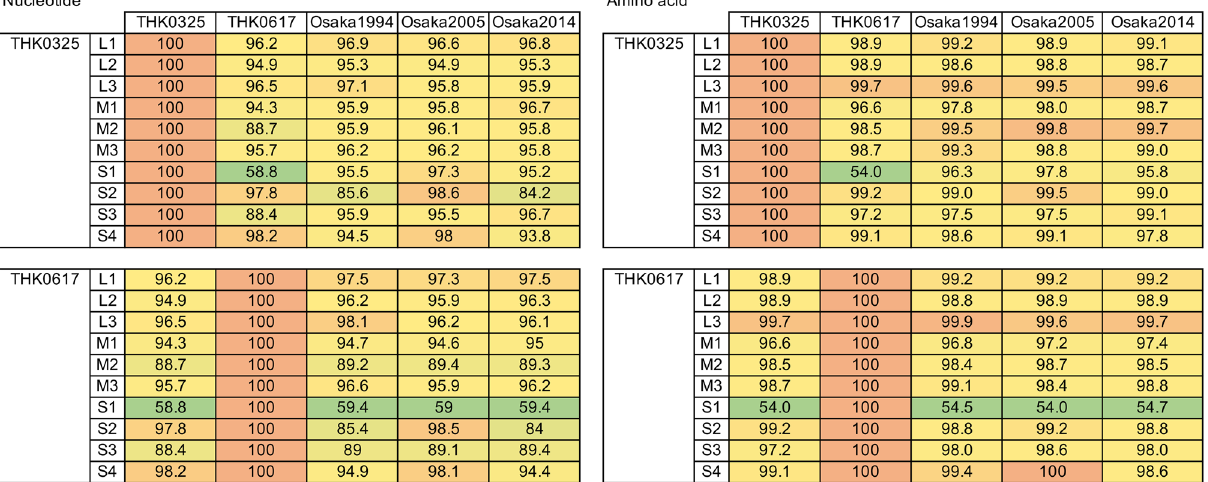
Figure 4. Pairwise sequence comparisons of MRV isolates. Nucleotide and amino acid identities between the novel isolates and MRV-2 Osaka strains previously isolated in Japan. Three-color scale formatting was applied to highlight the percentage values.